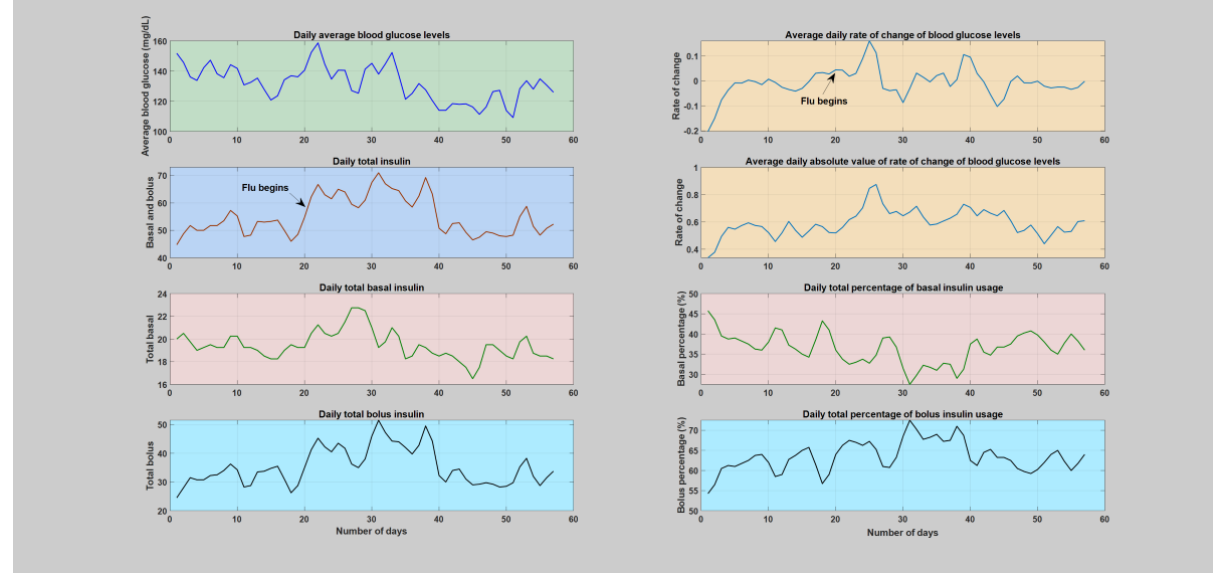
Figure 11. Daily analysis of the fifth infection case (flu). The figure depicts variation of average blood glucose levels, total insulin including both bolus and basal insulin, daily average rate of change of CGM and, absolute value of rate of change of CGM (computed based on CGM direction from the pump information), percentage of basal and bolus per total insulin units. As can be seen, as a result of the ongoing infection incidence, there is clear and dramatic rise in the amount of insulin, while blood glucose levels remain